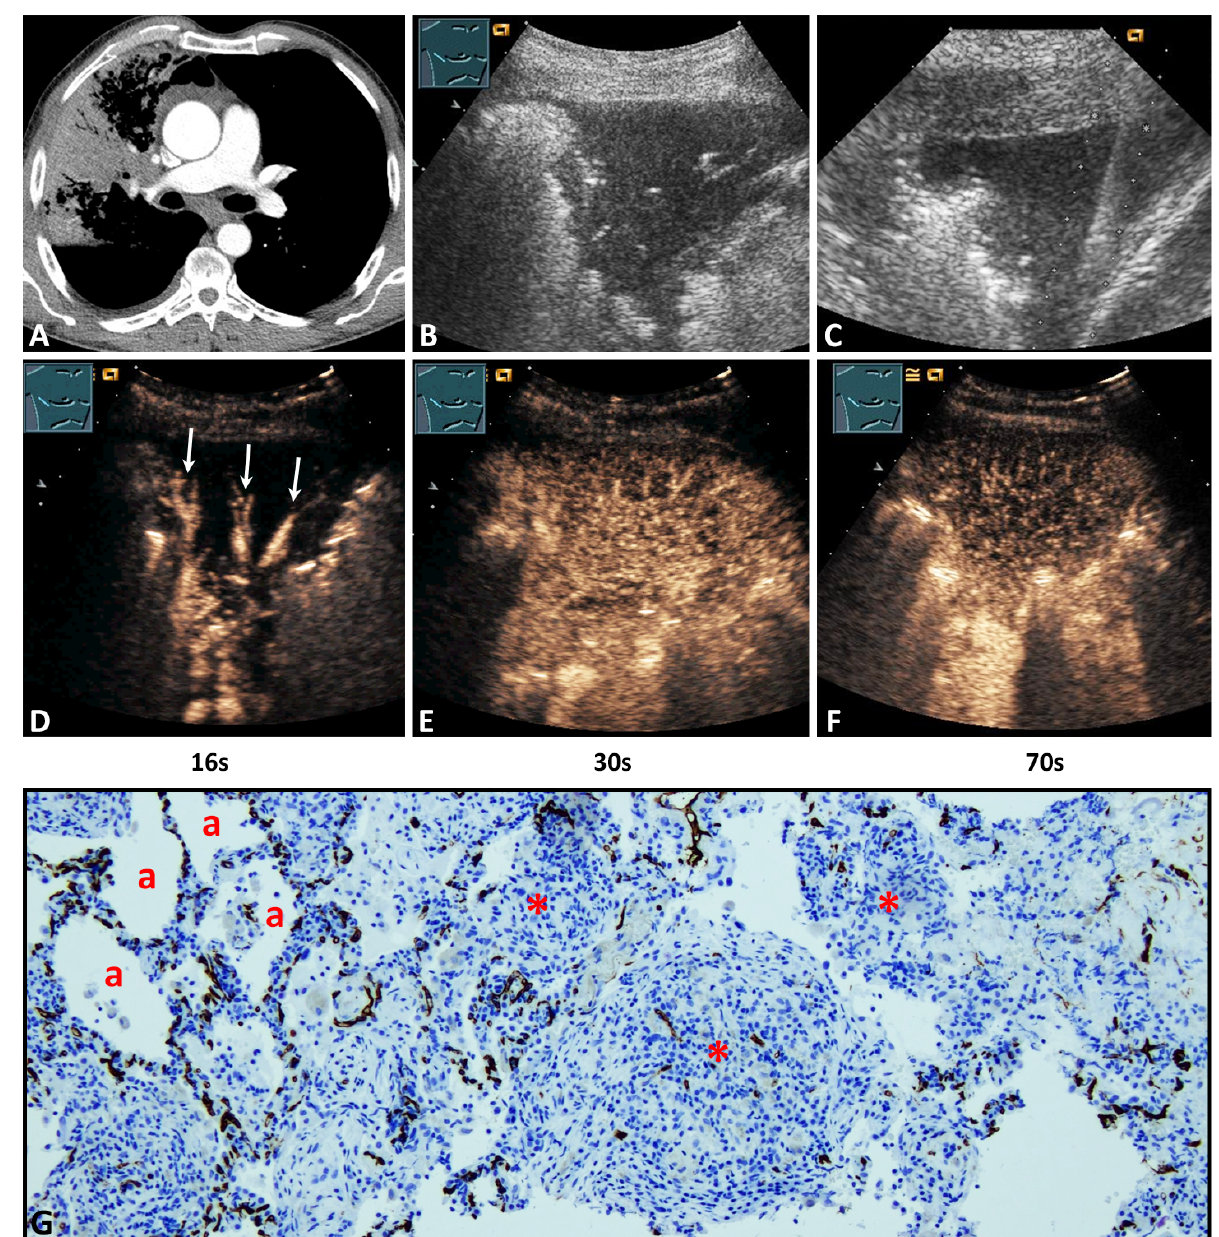
Figure 3. A 59-year-old male patient with lung consolidation on ( A ) computed tomography (courtesy of Prof. Dr. Andreas H. Mahnken, Department of Radiology, University Hospital Marburg) and ( B ) B-mode ultrasound. ( C ) An ultrasound-guided 18G-core needle biopsy of the lung lesion was performed. The histopathological examination of the lesion presents the diagnosis of organizing pneumonia. On contrast-enhanced ultrasound, the lesion showed ( D ) a pulmonary-arterial (arrows), ( E ) isoechoic, and homogenous pattern of enhancement ( F ) with an early decrease of enhancement. ( G ) In the tissue sample, immunohistochemical staining with CD34 was performed. To the left, preserved alveolar lung vasculature surrounding normal or macrophage-filled lung alveoli (a) is evident in favor of pattern A. On the right, reorganized lung tissue with fibrotic and granulating tissue with a high capillary density in a rather disorganized and chaotic pattern (*) is present, consistent with pattern B ( ×